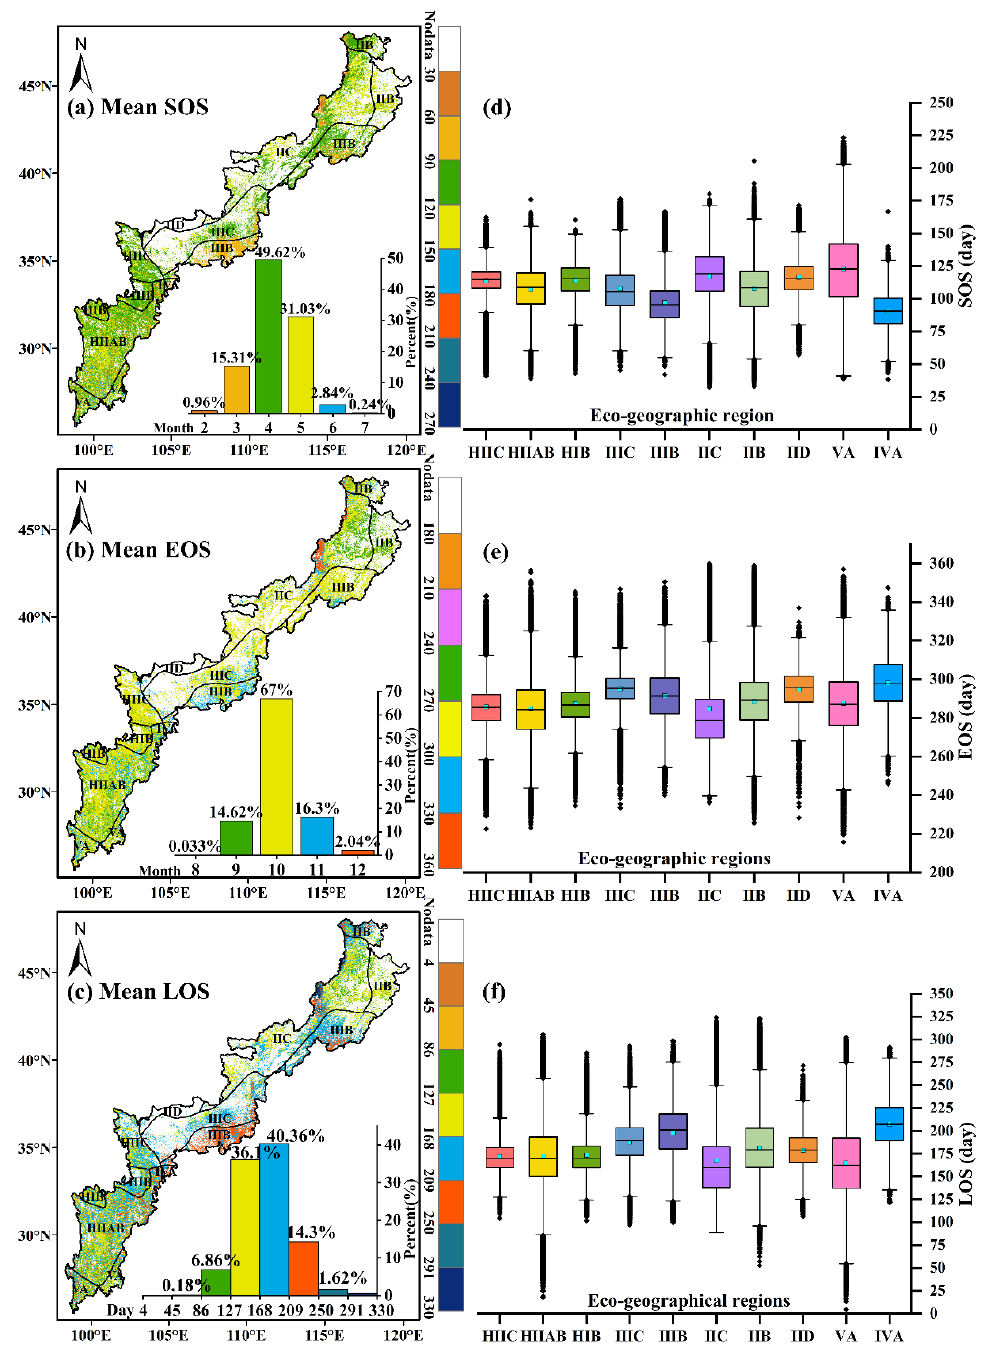
Figure 3. Spatial distribution of the multi-year mean values of the vegetation phenological periods in the agro-pasture ecotone. ( a – c ) indicate the mean changes of the SOS ( a ), EOS ( b ), and LOS ( c ) between 2000 and 2020, respectively. The histogram in the lower right corner indicates the percentage of the different color bands in the total; ( d – f ) Box plots of the mean SOS ( d ), EOS ( e ), and LOS ( f ) for the different eco ‐ geographic regions of the study area over 21 years, respectively.